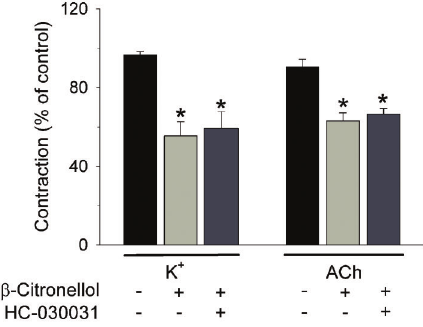
Figure 5. Evaluation of the involvement of the transient receptor potential ankyrin 1 (TRPA1) receptor in the myorelaxant effect of b -citronellol on rat trachea. Tracheal preparations were stimu- lated to contract in response to 60 mM K + or 5 m M acetylcholine (ACh) and, at the steady state of the contraction, 100 m M b -citronellol was added in the absence or presence of the TRPA1 antagonist HC-030031 (20 m M). The tracheal contraction induced by K + or ACh was reduced signi fi cantly by b -citronellol, an effect not in fl uenced by the presence of the TRPA1 antagonist. Data are reported as means ± SE. *P o 0.05 com- pared to control contractions induced by K + or ACh in the absence of both b -citronellol and HC-030031 (one-way ANOVA and Holm-Sidak